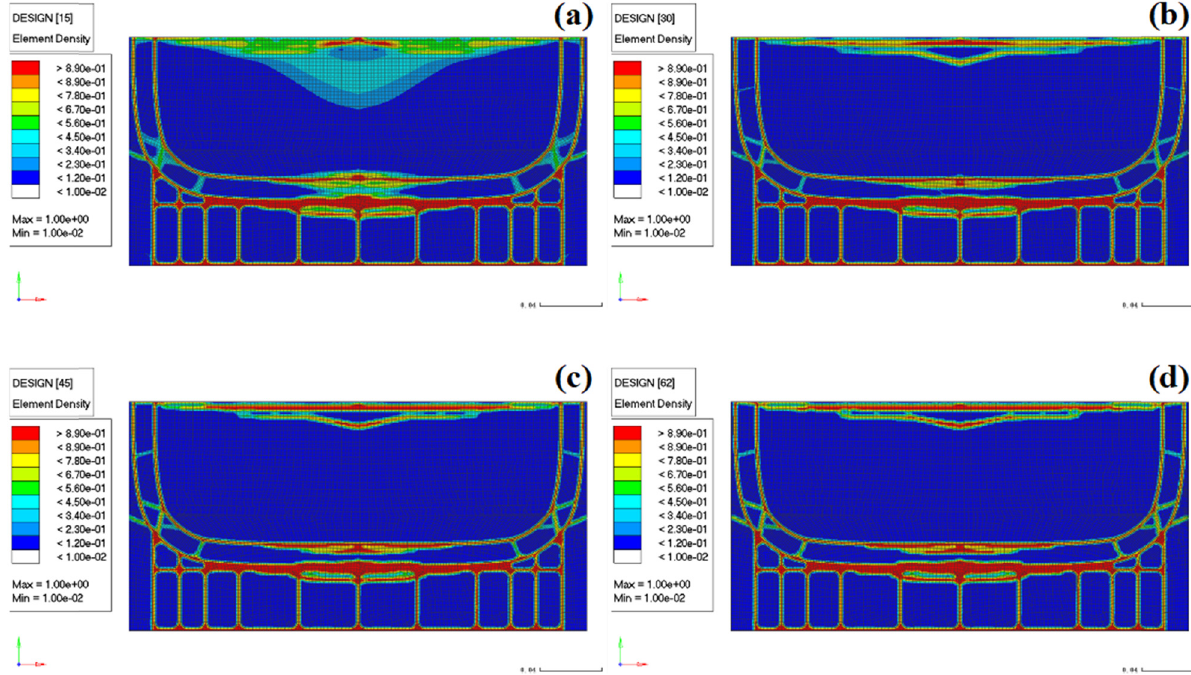
Figure 2: Iterative process of topology optimization. ( a ) Iteration 15, ( b ) iteration 30, ( c ) iteration 45, and ( d ) iteration